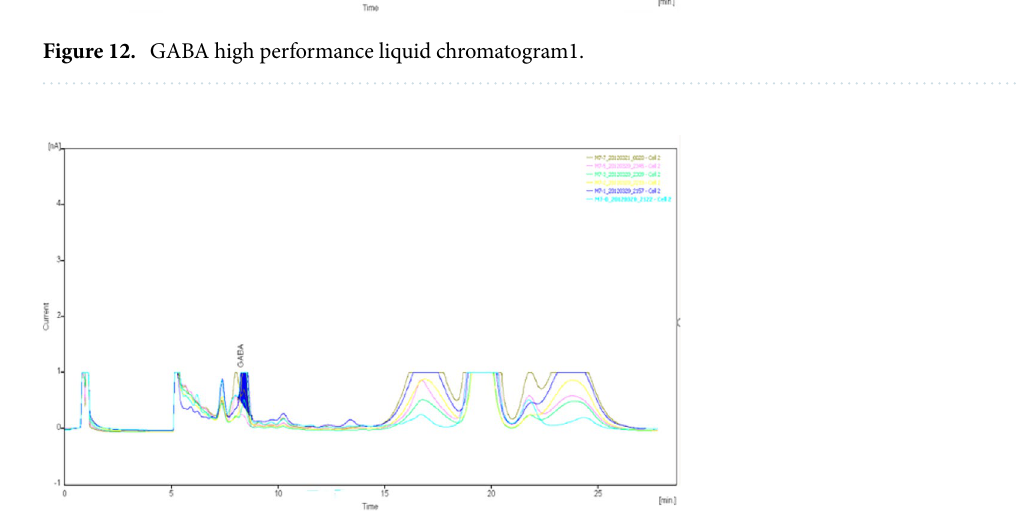
Figure 13. GABA high performance liquid